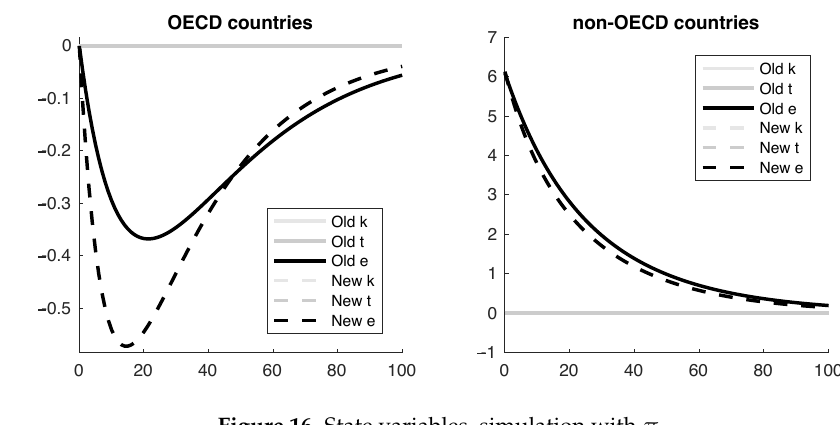
Figure 16. State variables, simulation with π .